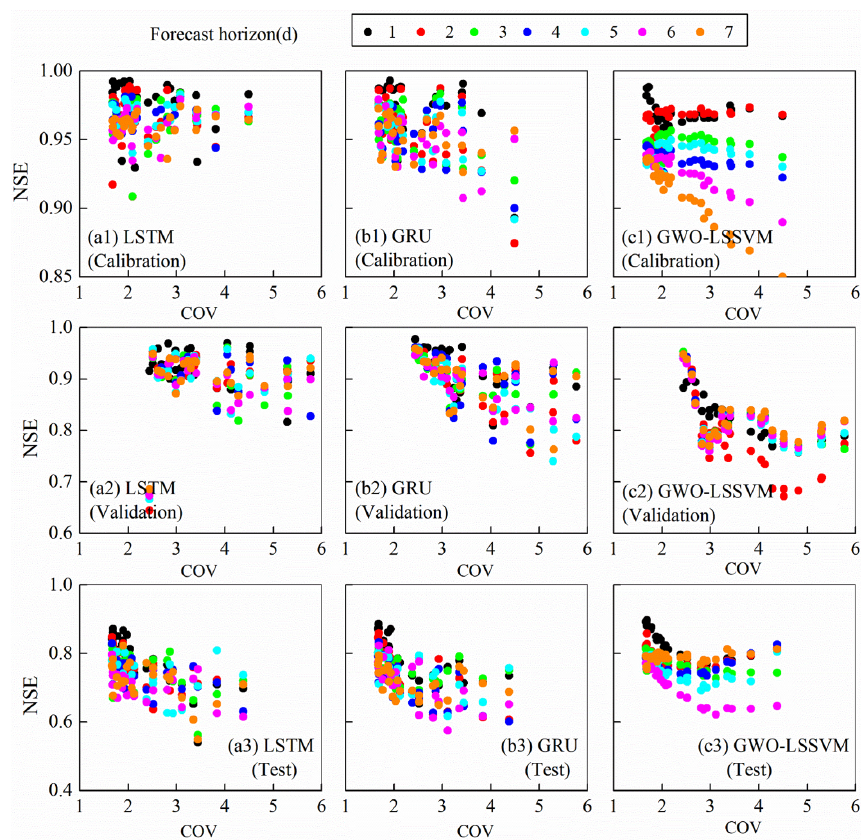
Figure 7. NSE values at lead times of 1 to 7d plotted against the coefficient of variation (COV) for all the 24 reservoirs during the period of (a) calibration, (b) validation, and (c) test S5.